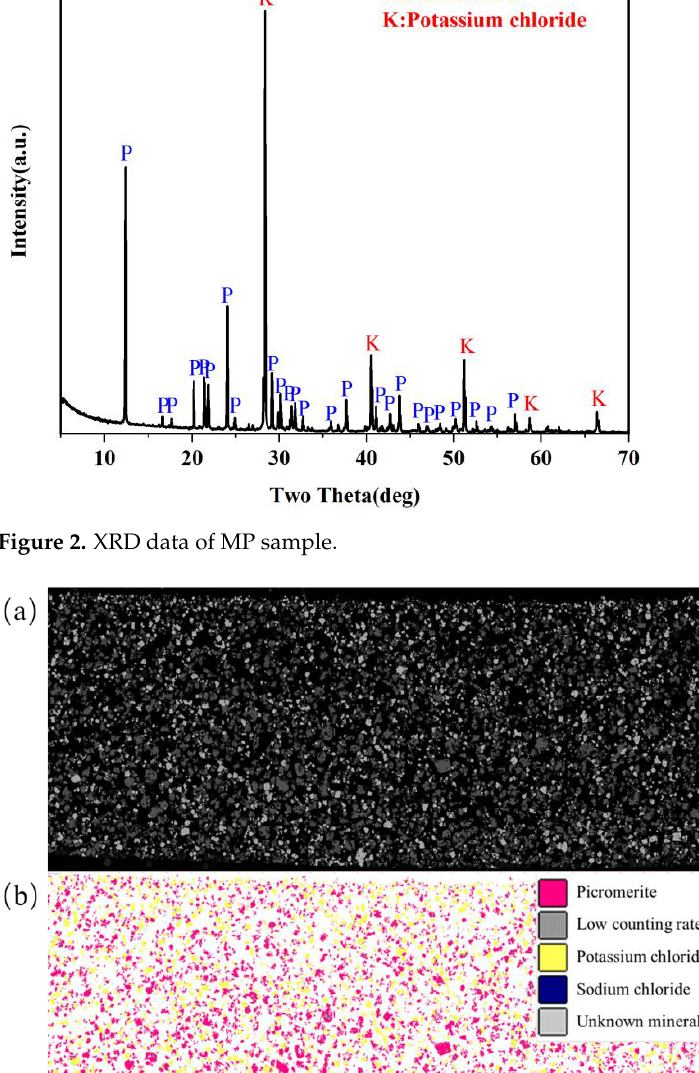
Figure 2. XRD data of MP sample.